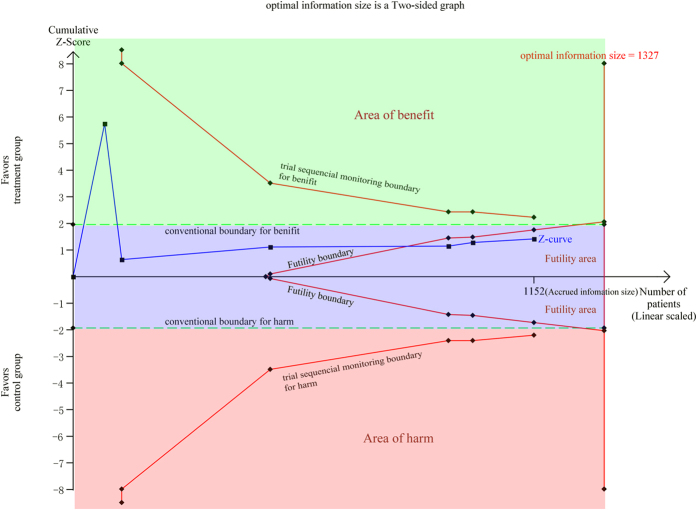
Trial sequential analysis of 6 trials for the association between early IMN and ARDS.The trial sequential analysis illustrating that the cumulative Z-curve crossed the Futility boundary and entered the Futility area, establishing sufficient and firm evidence that early IMN was not associated with higher risk of ARDS. The required optimal information size of 1,327 patients was calculated using α = 0.05 (two sided), β = 0.20 and a 25% control event rate (the rate of ARDS in the control group).